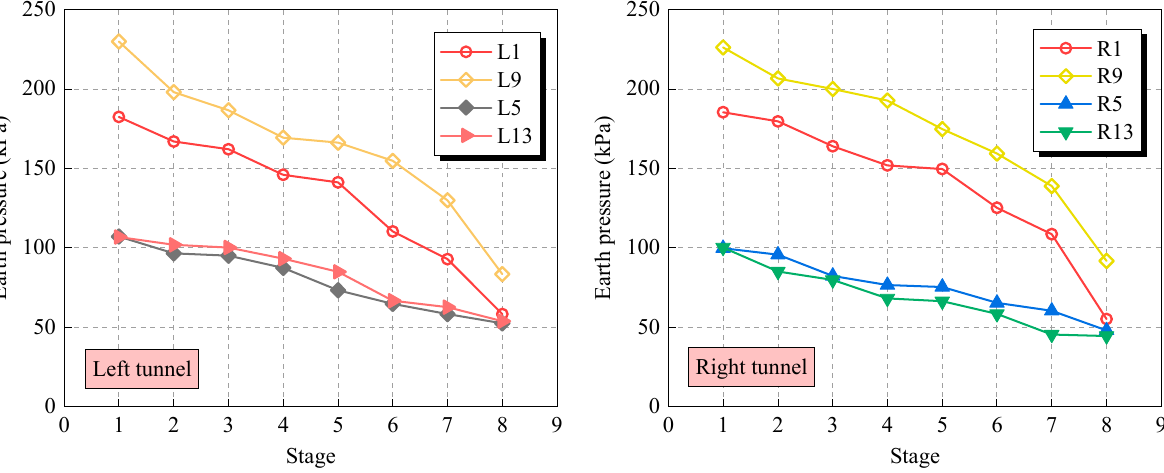
Figure 9. The earth pressure curve for different construction stages.